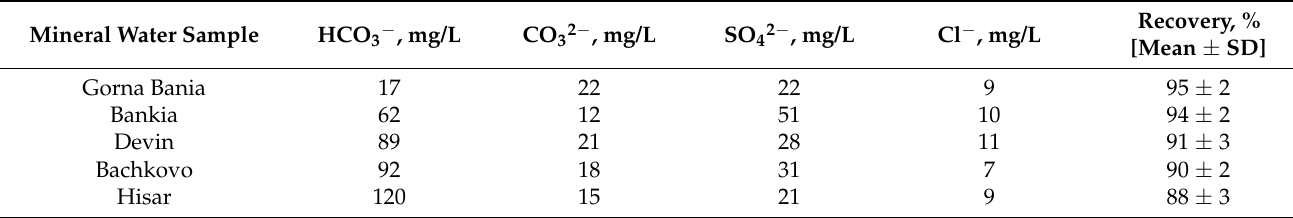
Table 4. Recoveries for U determination in mineral waters with different compositions (three parallel